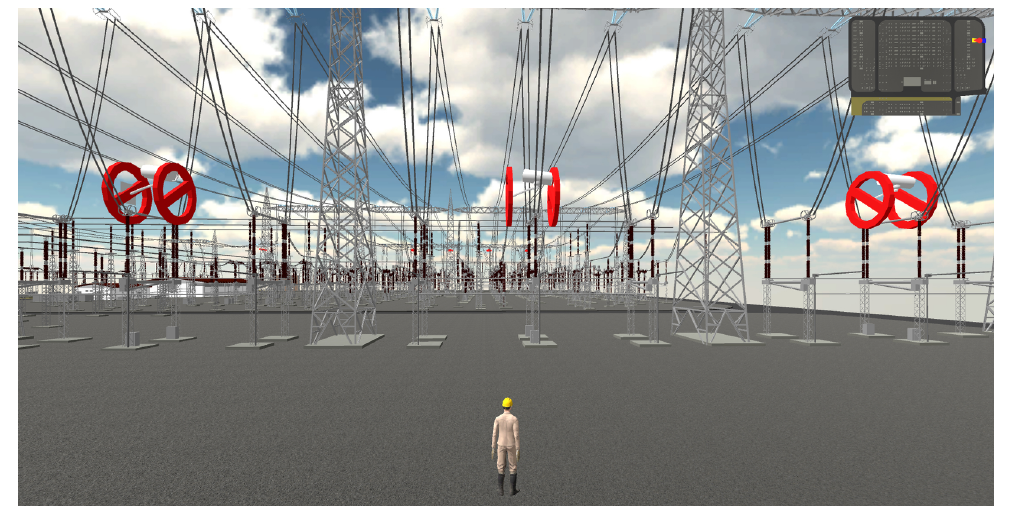
Figure 7. Initial state—all cameras